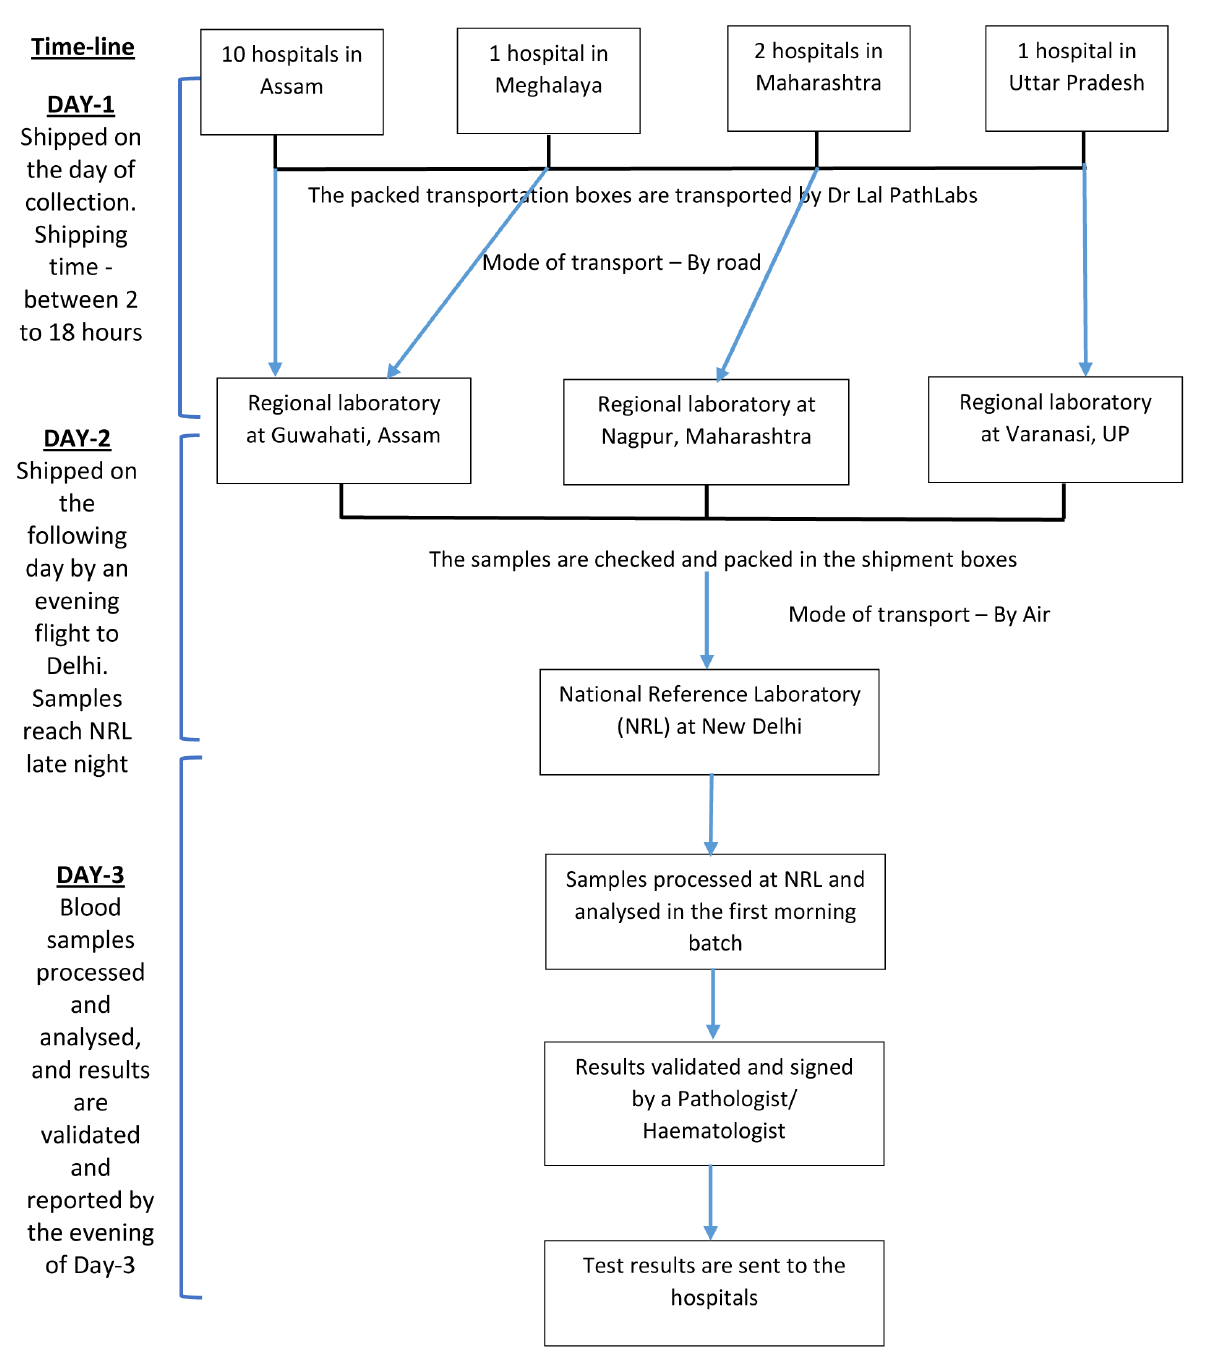
Figure 2. A flow-chart showing the transportation of samples from the hospital to the Dr Lal PathLabs National Reference Laboratory for processing and